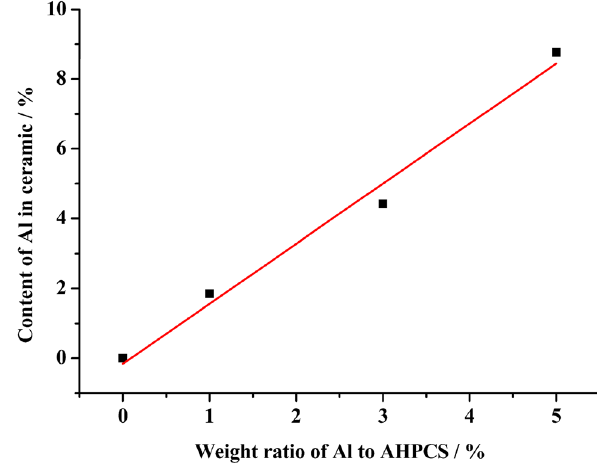
Figure 12: E ff ect of aluminum content in feed on the average crystal size of the fi nal ceramic at di ff erent temperatures.